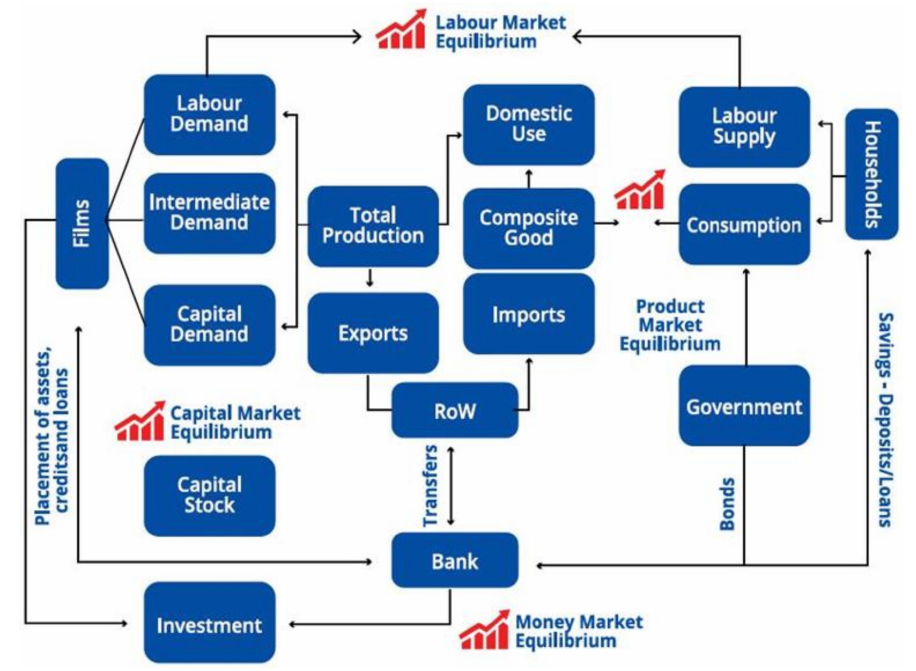
Figure 1. Overview of the GEM-E3-FIT